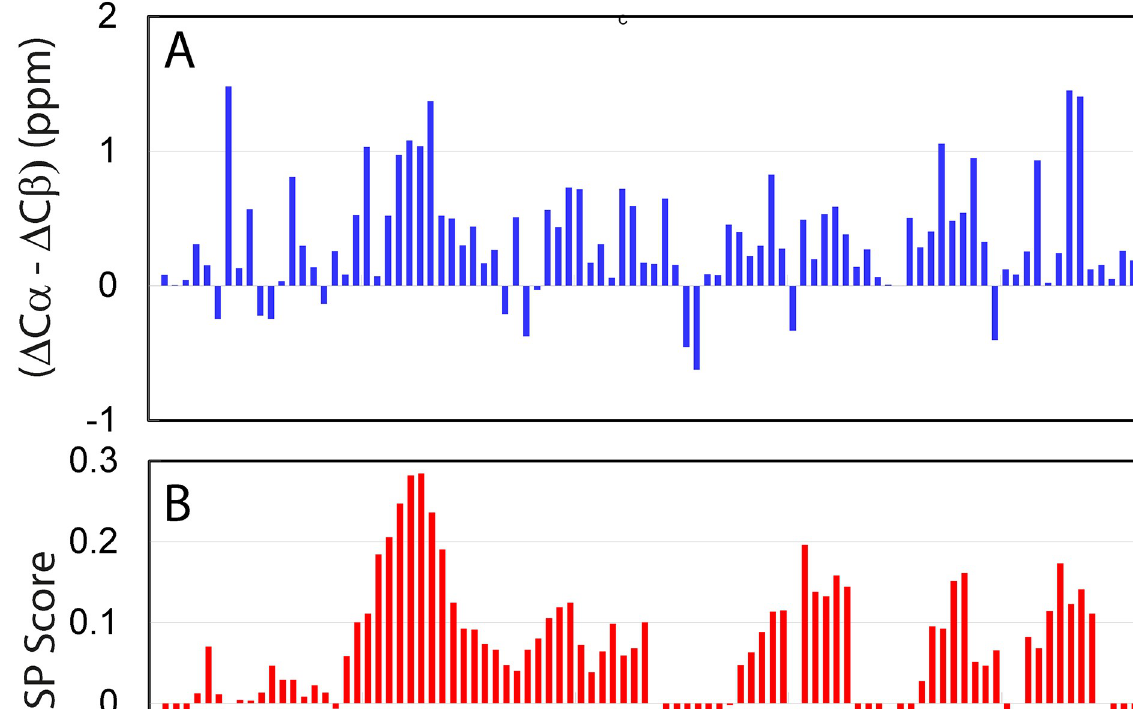
PLOS ONE | https://doi.org/10.1371/journal.pone.0205856 October 17,